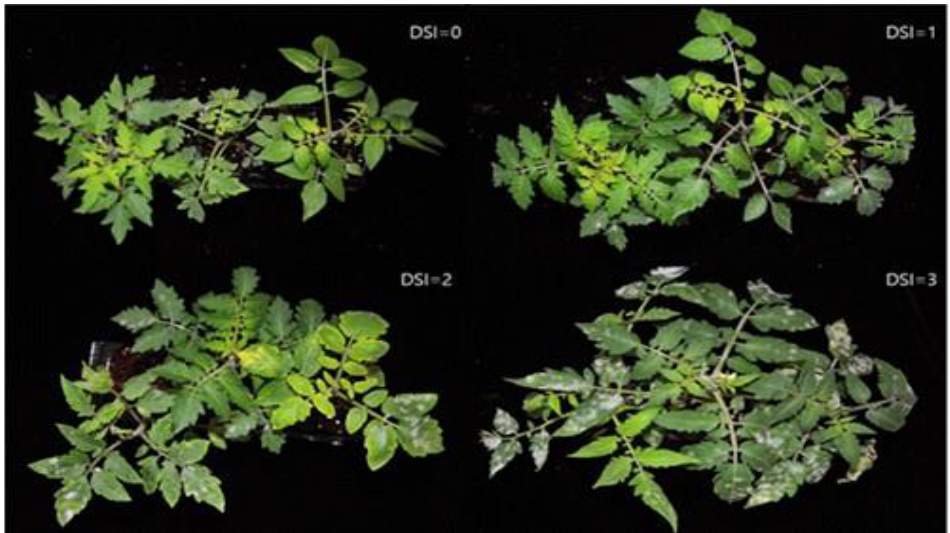
Figure 8. Disease severity rating scales used for assessing host plant resistance to powdery mildew in tomato. Disease severity index (DSI) was implemented based on visual rating scales of diseased leaf area (%) from the 1st to 6th true leaf. DSI = 0, 0%; DSI = 1, <10%; DSI = 2, 10–30%; and DSI = 3, >30%.